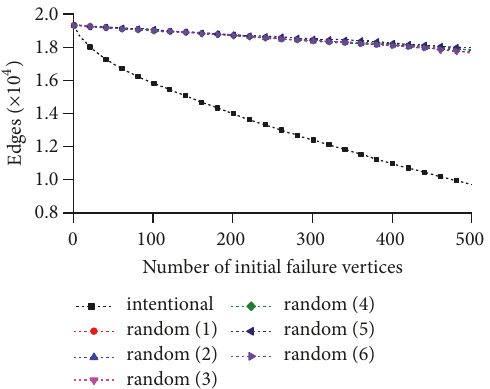
Figure 8: Relationships between the edges and the initial failure vertices in the networks.